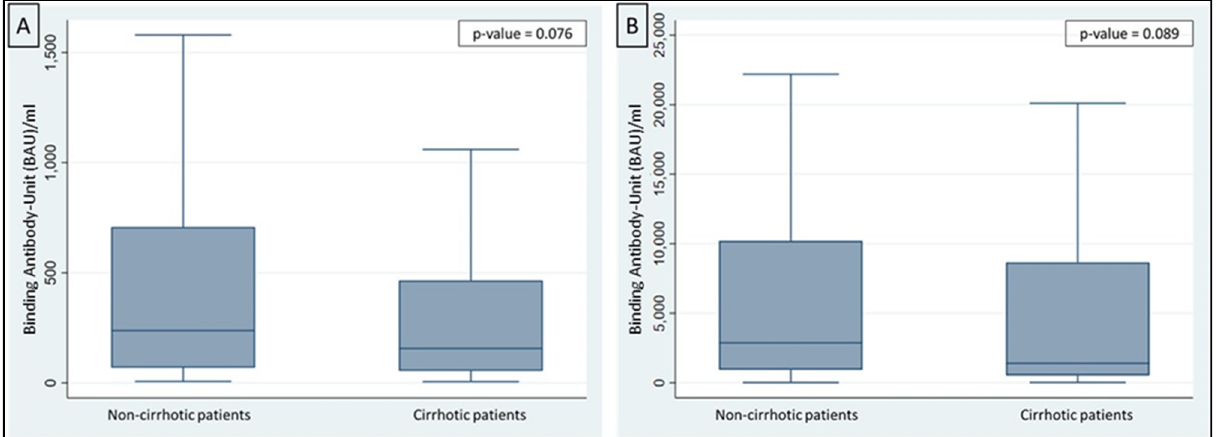
Figure 1. ( A ) Antibody titer in non-cirrhotic and in cirrhotic patients after primary vaccination course ( p -value = 0.076). ( B ) Antibody titer in non-cirrhotic and in cirrhotic patients after booster dose ( p -value = 0.089).